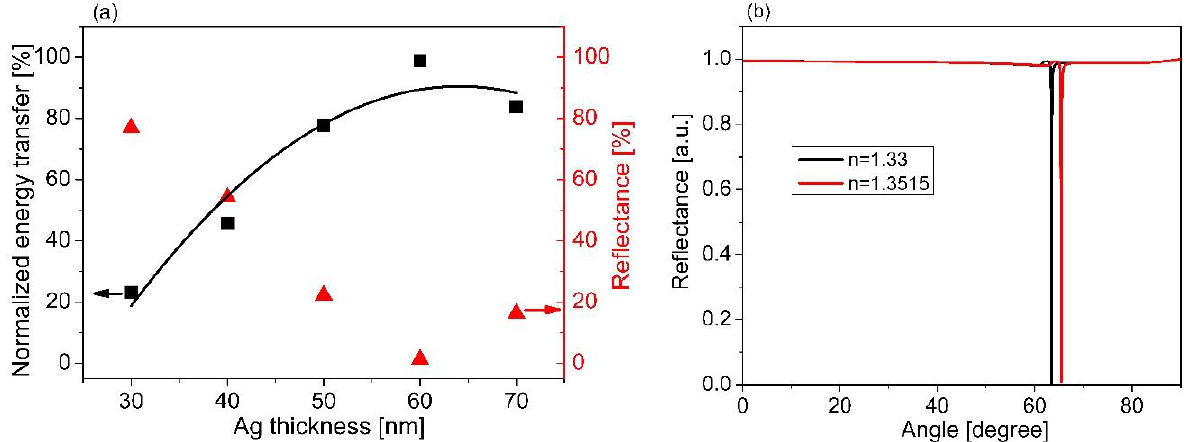
Figure 3. ( a ) The relationship between energy transfer and reflectance. ( b ) The change in resonance for different RI of the